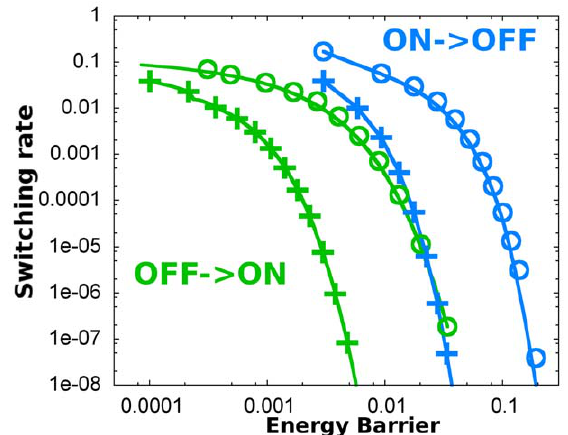
Figure 4. The asymmetry of switching rates does not disappear at larger volumes. Switching rates for different cell volumes as a function of the energy barrier. Switching rates (computed from Eq (16)) of the stochastic system with intrinsic multiplicative noise for an adimensonal cell volume V ~ 94 : 9 (circles) and for a larger volume V ~ 5 | 94 : 9 (crosses). The energy barrier heights were calculated from Eq (3). Blue color corresponds to ON to OFF switching and green corresponds to OFF to ON switching. The asymmetry of the switching rates is observed for both volumes. doi:10.1371/journal.pone.0031407.g004 drives larger absolute fluctuations in the ON state and elicit a faster switching rate from this state than from the OFF state for the same energy barrier height. Remarkably, this type of asymmetry is in agreement with the one reported experimentally for the gallactose signaling switch in yeast cells [6]: it is more probable to switch from the ON to the OFF state than viceversa.